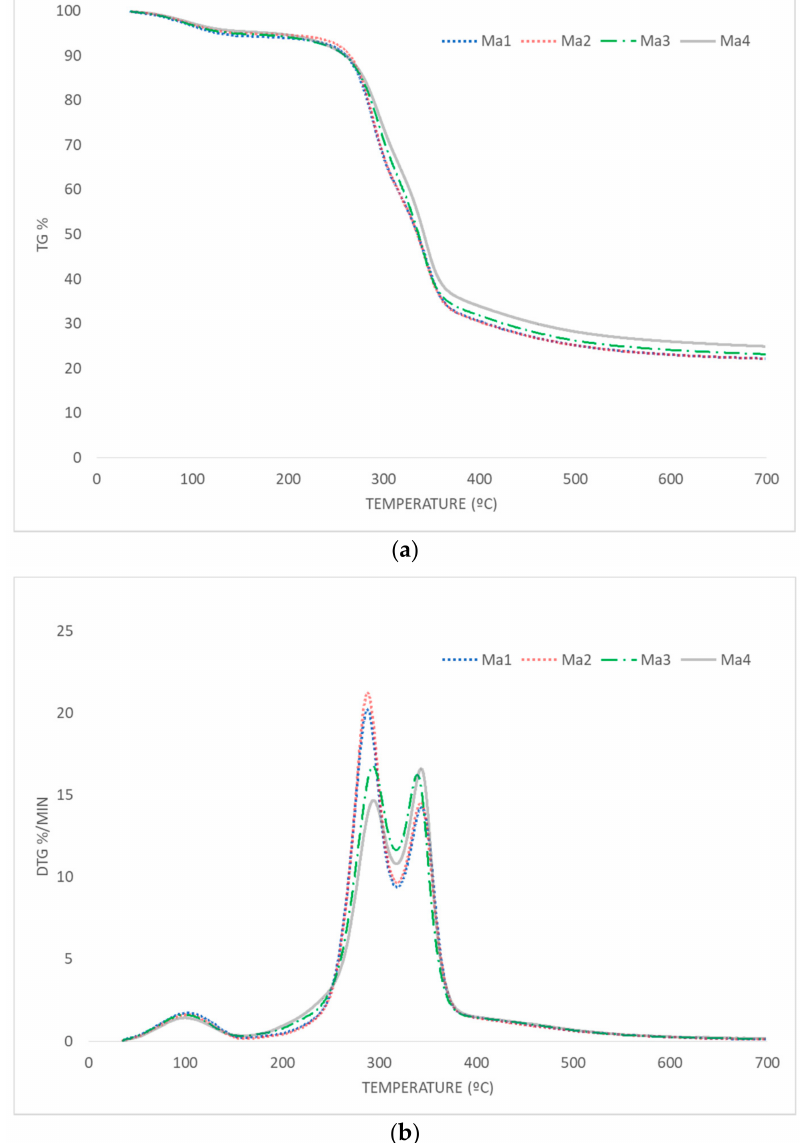
Figure 3. ( a ) Thermogravimetric (TG) pyrolysis and ( b ) DTG